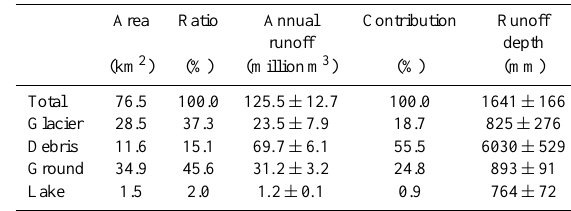
Table 2. Area, ratio of area, annual runoff, runoff contribution, and runoff depth of the Tsho Rolpa Glacial Lake–Trambau Glacier basin for different surface types. Errors represent interannual variability calculated for the period 1979–2007 (28